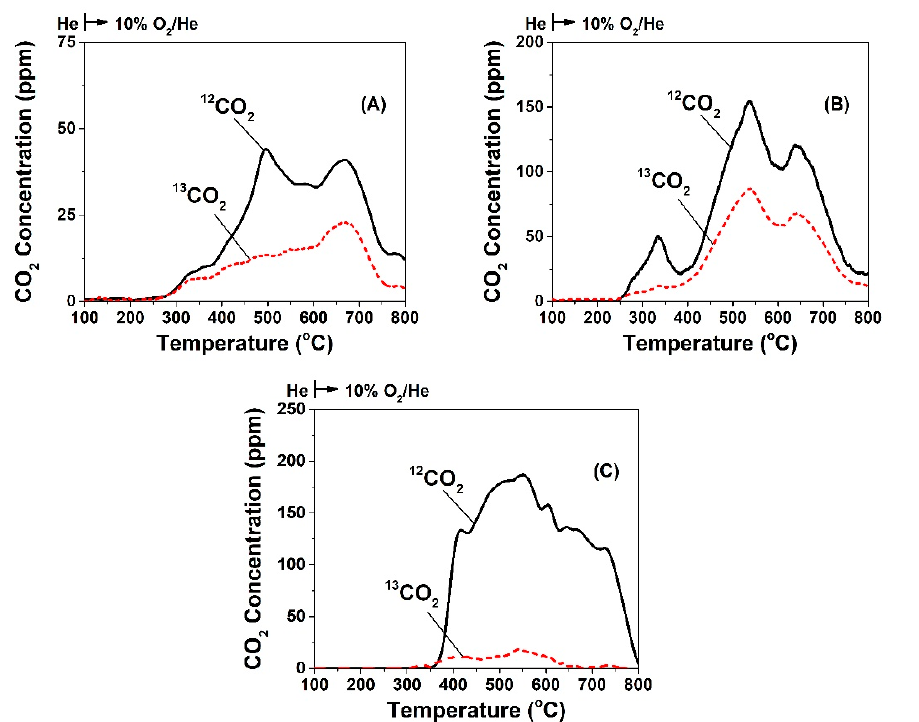
Figure 4. Temperature-programmed oxidation (TPO) of carbon to 12 CO 2 and 13 CO 2 formed after 30 min in 5 vol% 13 CO 2 /5 vol% 12 CH 4 /45 vol% Ar/45 vol% He (50 NmL min − 1 ; GHSV ∼ 30,000 h − 1 ) at 750 ◦ C over ( A ) 5 wt% Ni / CeO / CeO / CeO °C over ( A ) 5 wt% Ni/CeO 2 -TD, ( B ) 5 wt% Ni/CeO 2 -HT, and ( C ) 5 wt% Ni/CeO 2 -SG. 750 2 -TD, ( B ) 5 wt% Ni 2 -HT, and ( C ) 5 wt% Ni 2